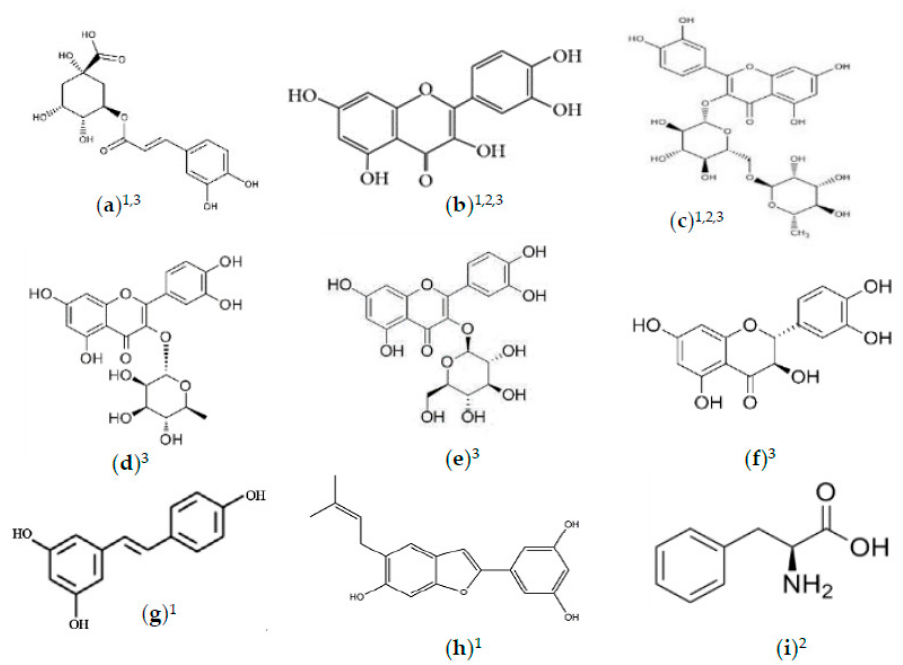
Figure 1. Natural compounds in M. alba with antioxidative abilities. ( a ) Chlorogenic acid; ( b ) quercetin; ( c ) rutin; ( d ) quercitrin; ( e ) isoquercitrin; ( f ) dihydroquercetin; ( g ) resveratrol; ( h ) moracin; ( i ) phenylpropanoids. 1 Refers to compounds in M. alba leaves; 2 refers to compounds in M. alba fruit; 3 refers to compounds in M. alba seeds.